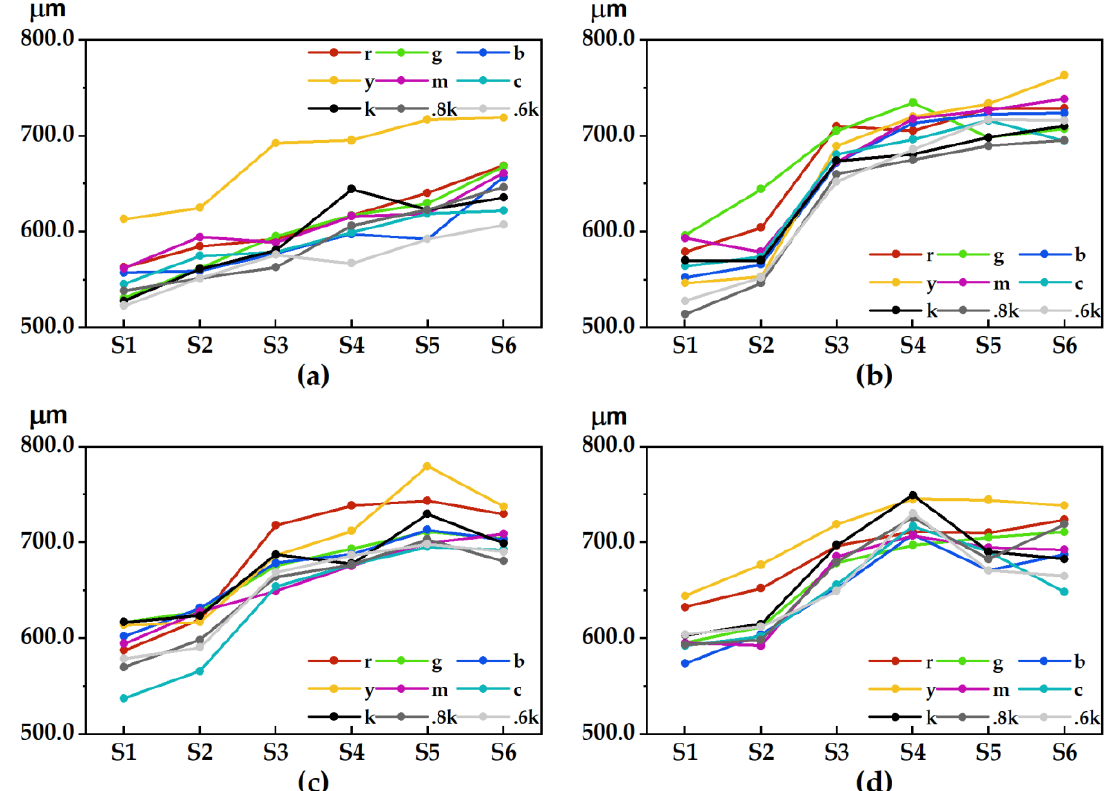
Figure 2. The lateral pigment penetration depth: ( a ) test plate I; ( b ) test plate II; ( c ) test plate III; ( d ) test plate